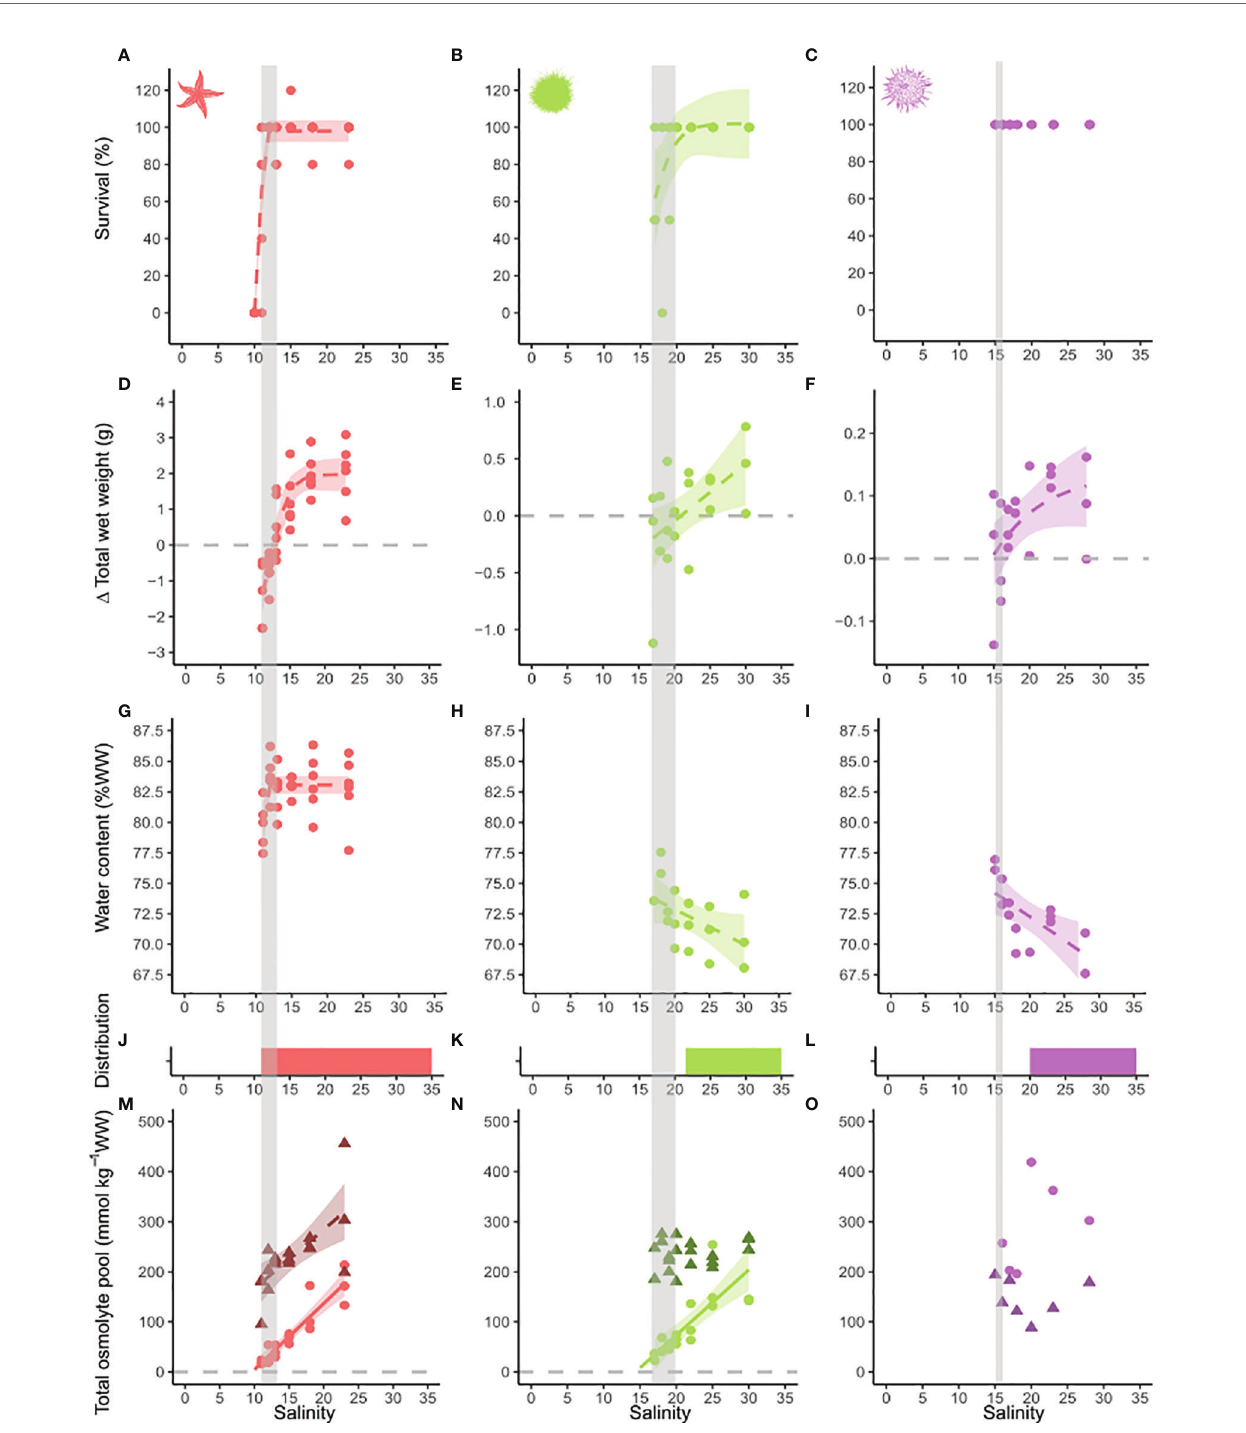
FIGURE 2 | Effect of long-term low salinity acclimation on survival, growth, water content, distribution and osmolyte pool size on common star fi sh, green sea urchins and shore sea urchins. Salinity is depicted on the x-axis. On the y-axis survival is presented in %, (A – C) change in total wet weight in g, (D – F) water content in % wet weight (G – I) and osmolyte pools in mmol per kg weight wet. (M – O) Osmolyte pools were corrected for relative weight change due to increases in water content with decreasing salinity. Colored bars represent the species ’ known salinity range in the Baltic Sea (J – L) . The legend and further graph descriptions are addressed in Figure 1 . Species are marked by color code and symbol: red - common star fi sh ( Asterias rubens ), green - green sea urchins ( Strongylocentrotus droebachiensis ) and purple - shore sea urchins ( Psammechinus milliaris ). Grey vertical bars represent the critical salinity range derived from the salinity thresholds of the measurements of physiological and biochemical